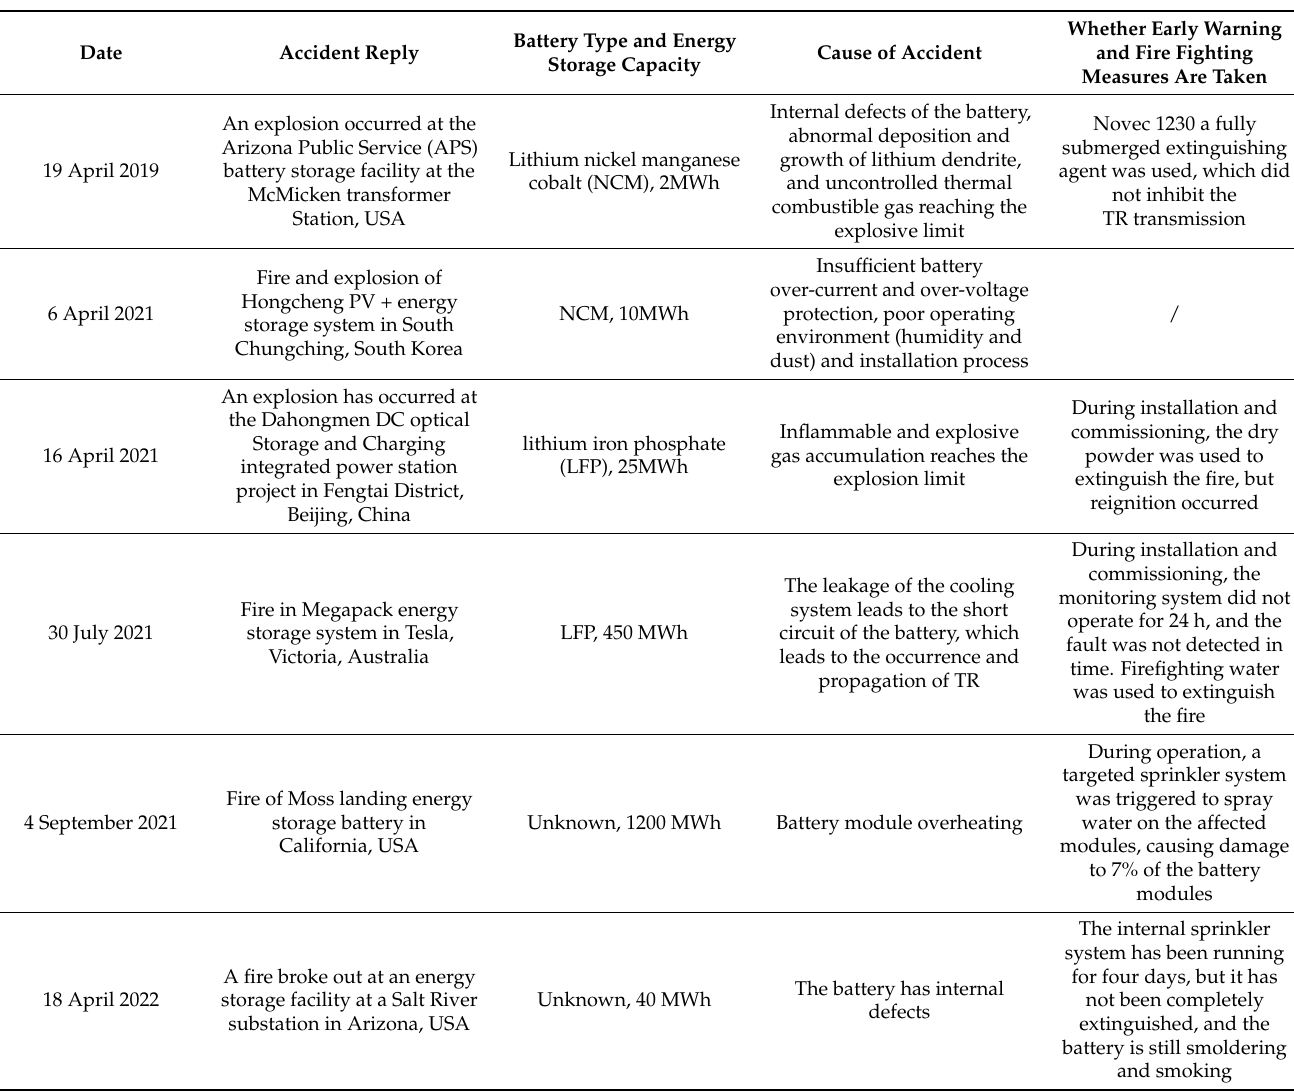
Table 1. Several typical LIB safety accidents